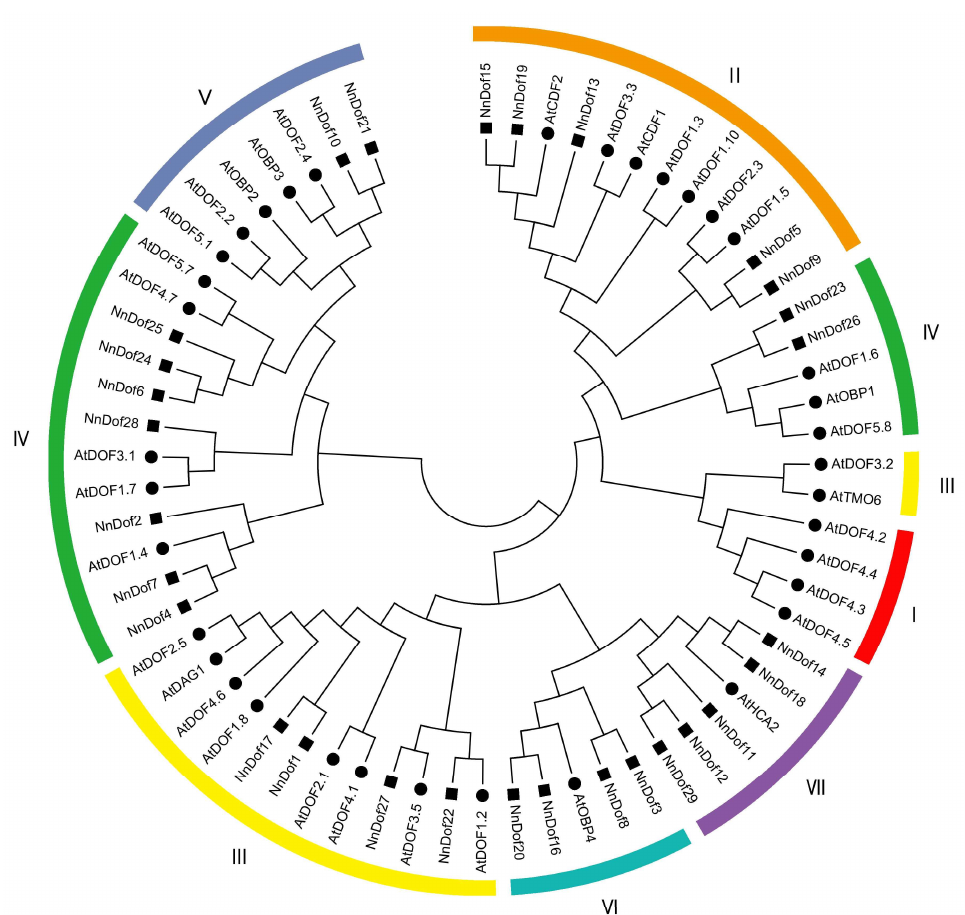
Figure 1. Phylogenetic tree of Dof transcription factors in N. nucifera and A. thaliana . The phylogenetic tree was created using MEGA 6.0, with the neighbor-joining method and bootstrap value set at 1000. Black circles represent the 36 AtDof proteins, and the 29 NnDof proteins are marked with black squares. The resulting phylogenetic tree was clustered into seven main groups, labeled I, II, III, IV, V, VI, and